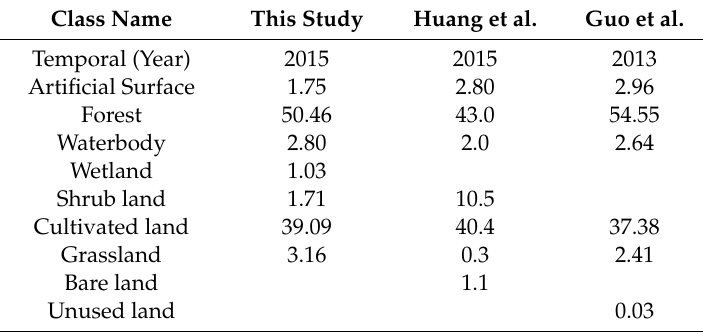
Table 5. The comparison of land use type’s areas percentage in the TGRC from various studies. Class Name This Study Huang et al. Guo et